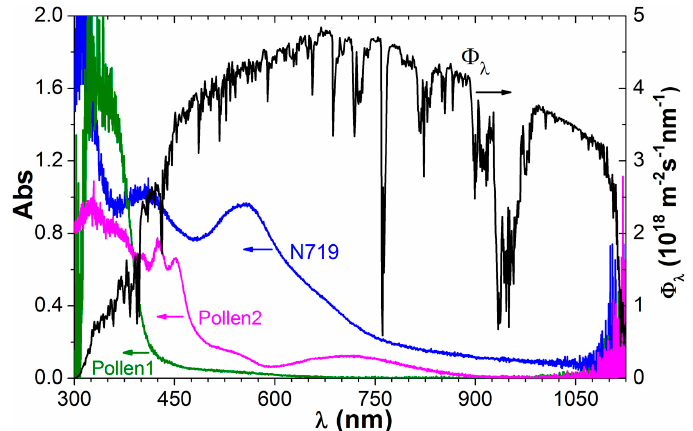
Figure 2. Spectra of pollen extracts with Solutions 1 and 2 and artificial dye N719 spectrum. Right y axis : Spectral photon density, Φ λ , calculated from the standard ASTM G173-03 reference solar